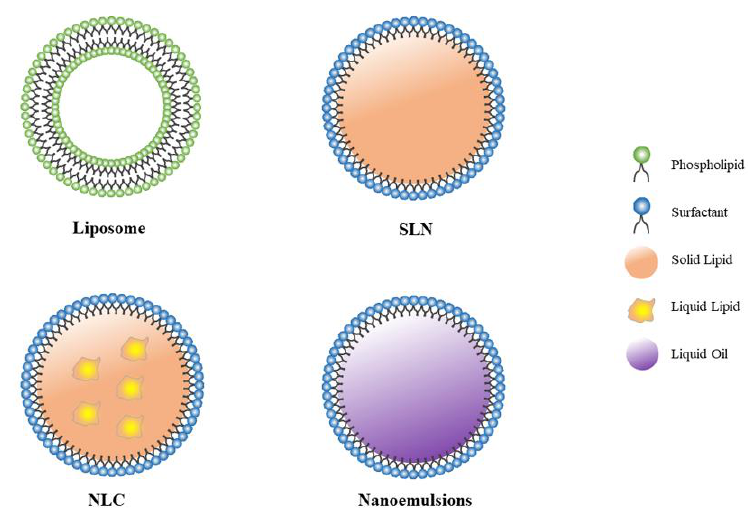
Figure 6. Types of LNPs used for siRNA pulmonary delivery.